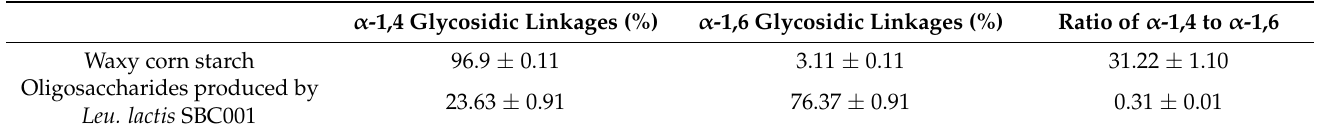
Table 4. The proportion of glycosidic linkages in oligosaccharides and waxy corn starch (WCS). α -1,4 Glycosidic Linkages (%) α -1,6 Glycosidic Linkages (%) Ratio of α -1,4 to α -1,6 Waxy corn starch 96.9 ± 0.11 3.11 ± 0.11 31.22 ± 1.10 Oligosaccharides produced by 23.63 ± 0.91 76.37 ± 0.91 0.31 ± Leu. lactis SBC001